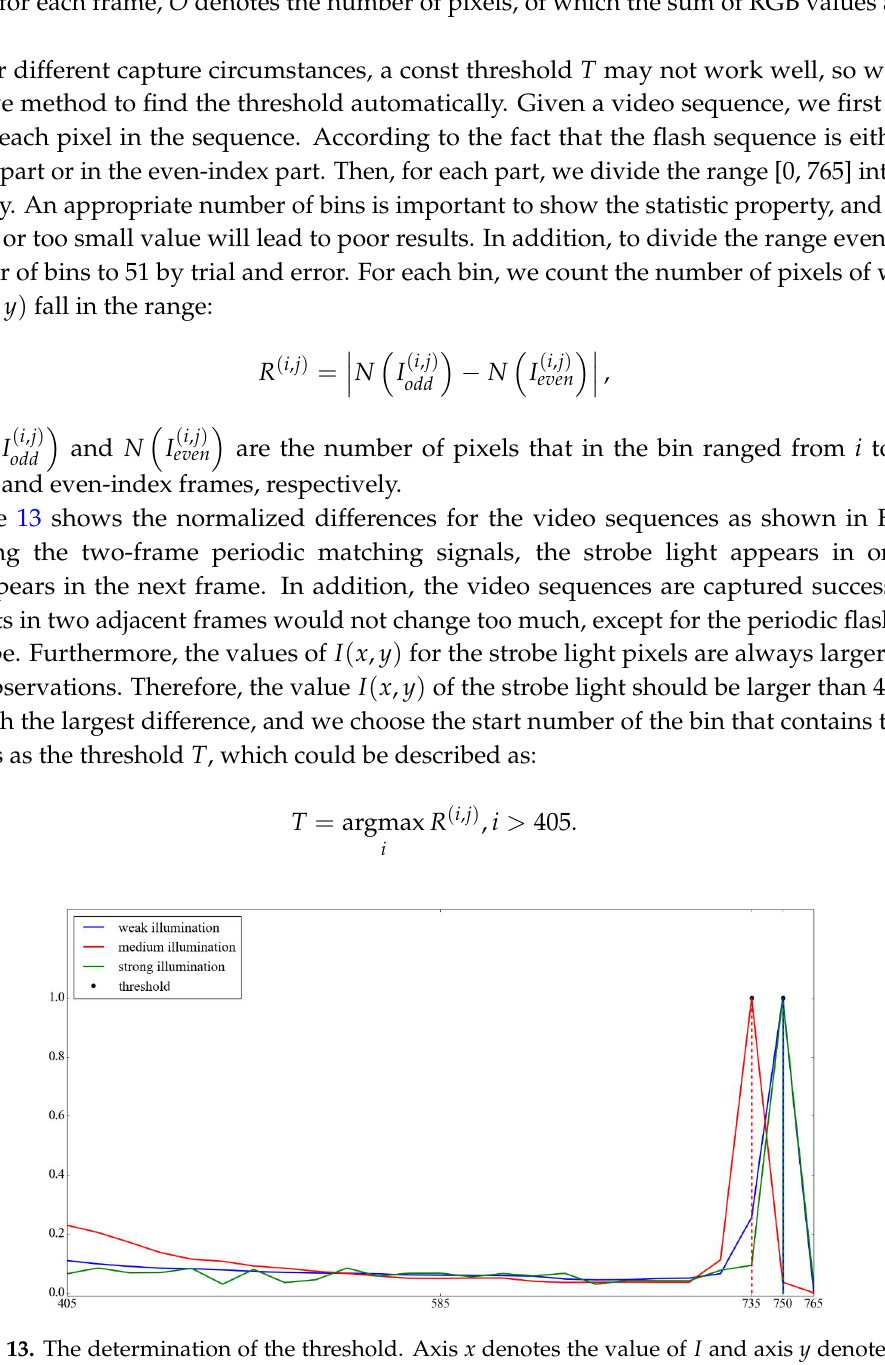
Figure 13. The determination of the threshold. Axis x denotes the value of I and axis y denotes the normalized difference value between the odd-index and even-index frames. The curves shows the normalized differences between the odd-index and even-index frames for each bin, captured under different illumination circumstances in the range from 405 to 765. The start number of the bin with the largest difference is chosen as the